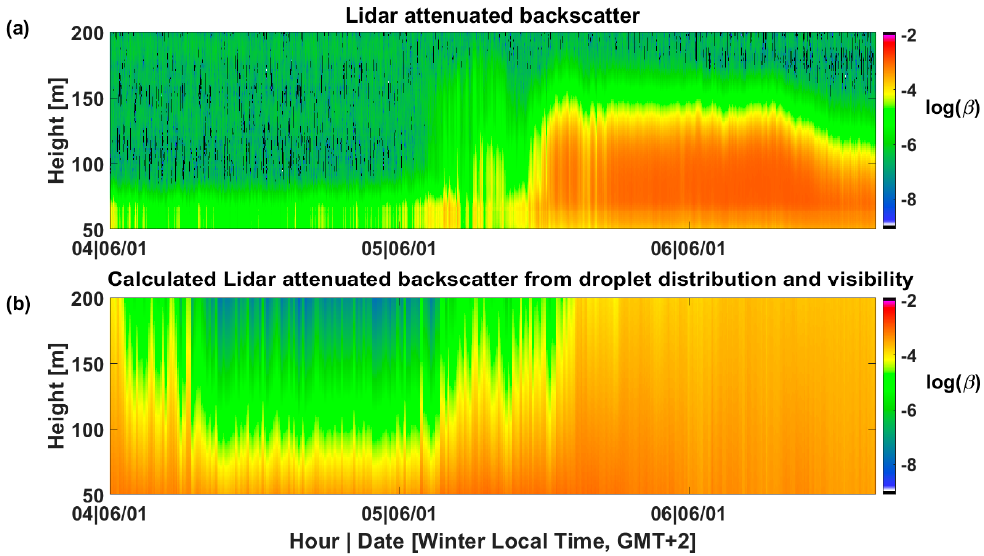
Figure 15. ( a ): StreamLine XR Lidar measurement of β during the fog event of 6 January 2021 between 4 a.m. to 7 a.m. local time. ( b ): Calculated values of β according to the Lidar equation based on mass extinction and backscatter coefficients.